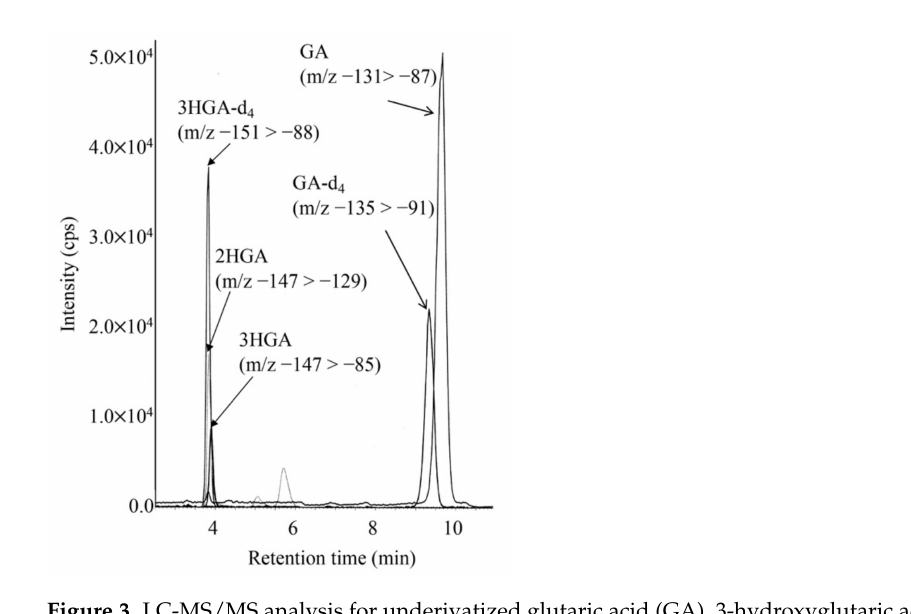
Figure 3. LC-MS/MS analysis for underivatized glutaric acid (GA), 3-hydroxyglutaric acid (3HGA), and 2-hydroxyglutaric acid (2HGA) using negative ion mode. The gradient elution program was as follows: 0% B (5 min), 0% to 30% B (6 min), 30% to 100% B (0.1 min), 100% B (7.9 min), 100% to 10% B (0.1 min), and 13% B (5 min).